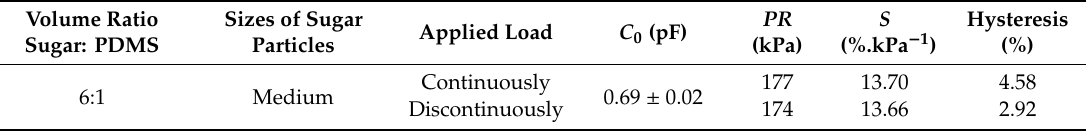
Figure 10. Variation of the capacitance according to the applied pressure, depending on the dynamics of the applied load (continuously or discontinuously with 10 pauses at each measurement point) for a 6:1 medium pore, porous PDMS that was 5 mm thick.